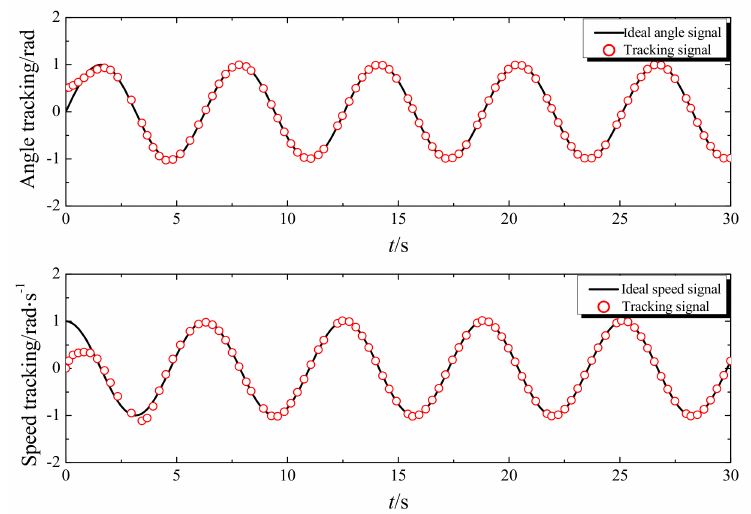
Figure 11. Angle and speed tracking